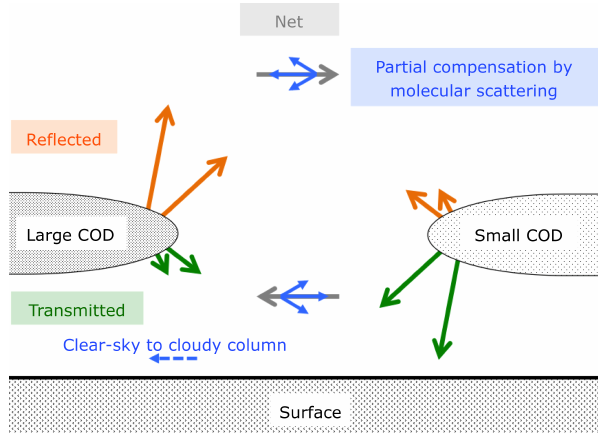
Figure 5. Conceptual visualization of the mechanism of horizontal photon